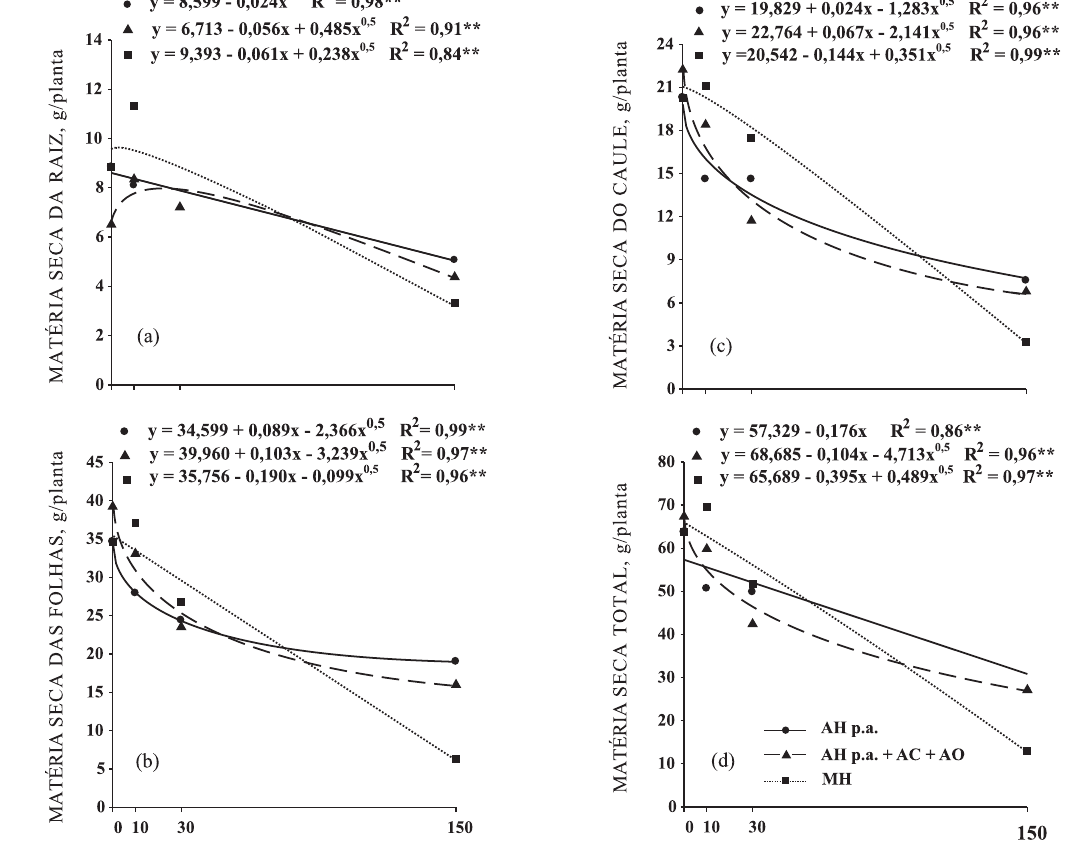
significativo.Figura 2. Matéria seca de raiz (a), folhas (b), caule (c) e total (d) de mudas de eucalipto em resposta ao aumento de concentrações de C-ácido húmico em solução nutritiva. AH p.a.: ácido húmico p.a.; MH: material húmico; AC: ácido cítrico; AO: ácido